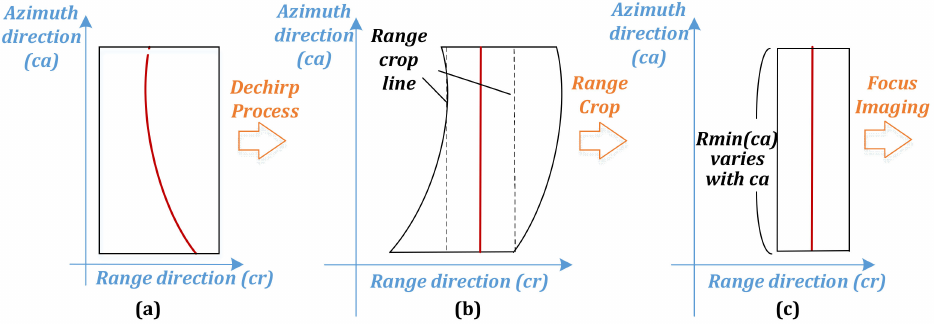
Figure 7. ( a ) Curved range history of the target; ( b ) after dechirp; ( c ) after range crop along